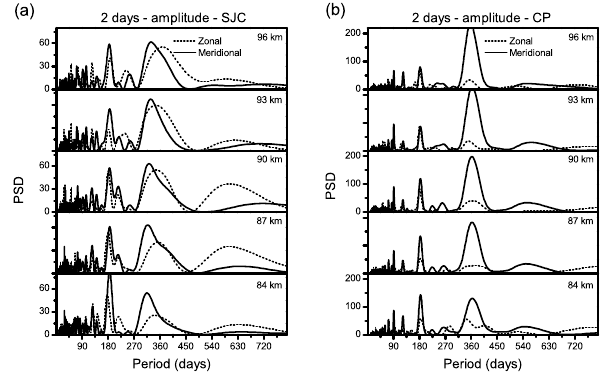
Figure 5. Lomb–Scargle periodograms obtained from amplitudes Fig. 5. Lomb-Scargle periodograms obtained from amplitudes of the QTDW for the zonal (dotted) and meridional (solid) winds obtained on of the QTDW for the zonal (dotted line) and meridional (solid line) (a) Cariri and (a) C. Paulista for altitudes between 84 km and 96 km. winds obtained over (a) Cariri and (b) C. Paulista for altitudes be- tween 84km and